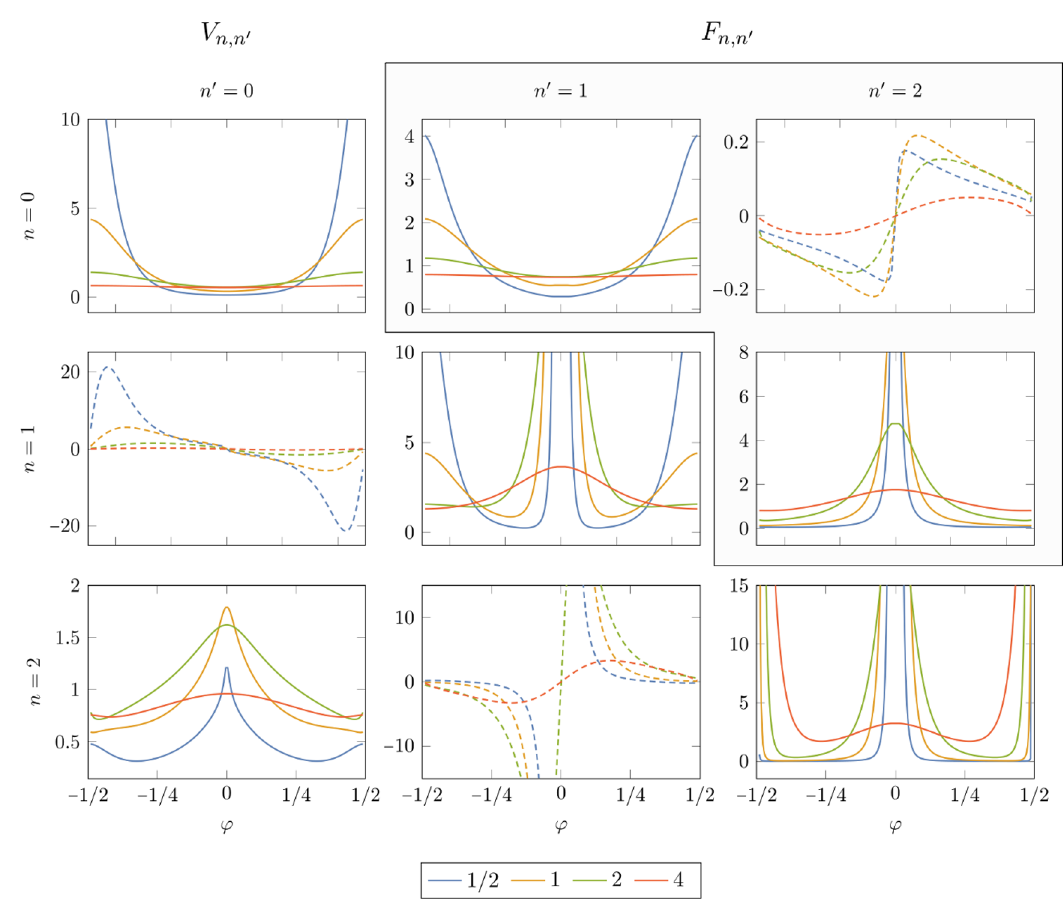
Figure 5. V n;n 0 (bottom left panels) and F n;n 0 (top right panels) for q = 1 = 2, 1, 2 and 4. Solid lines represent real-valued potentials and dashed are purely imaginary. The V n;n 0 and F n;n 0 are plotted in units of ~ 2 = (2 f 2 ) and ~ =f 2 ,